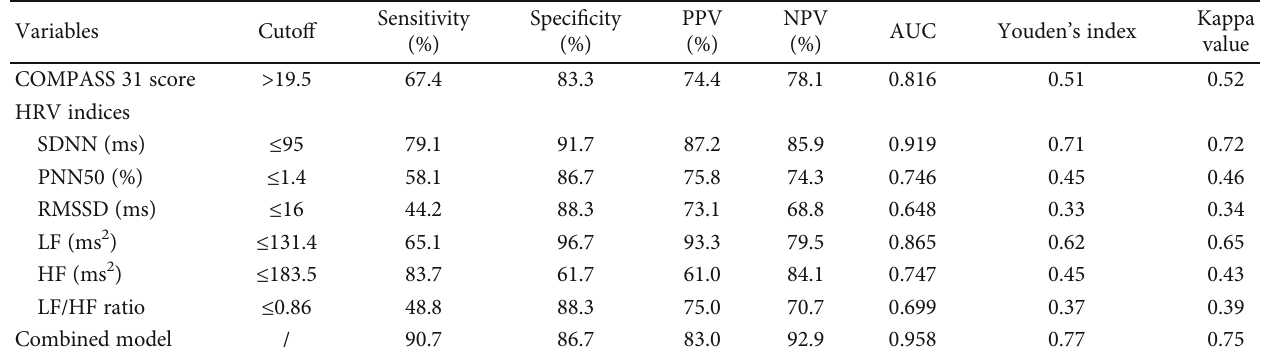
Table 4: Comparison of diagnostic value among COMPASS 31 score and HRV indices.